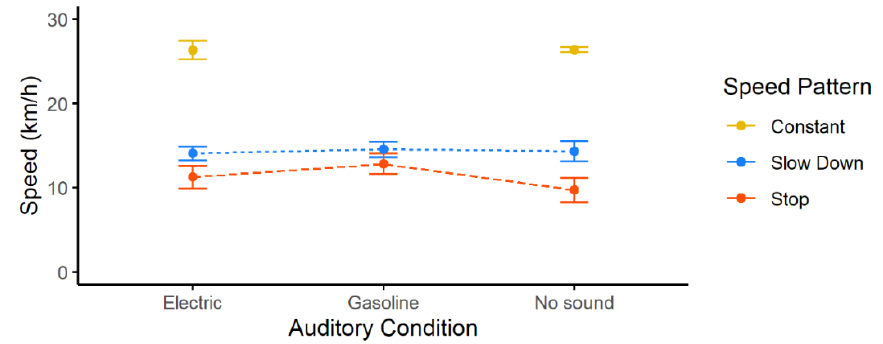
Figure 8. Mean speed of the vehicle at the moment of the participants’ response and respective mean standard error as a function of auditory condition per vehicle speed pattern.